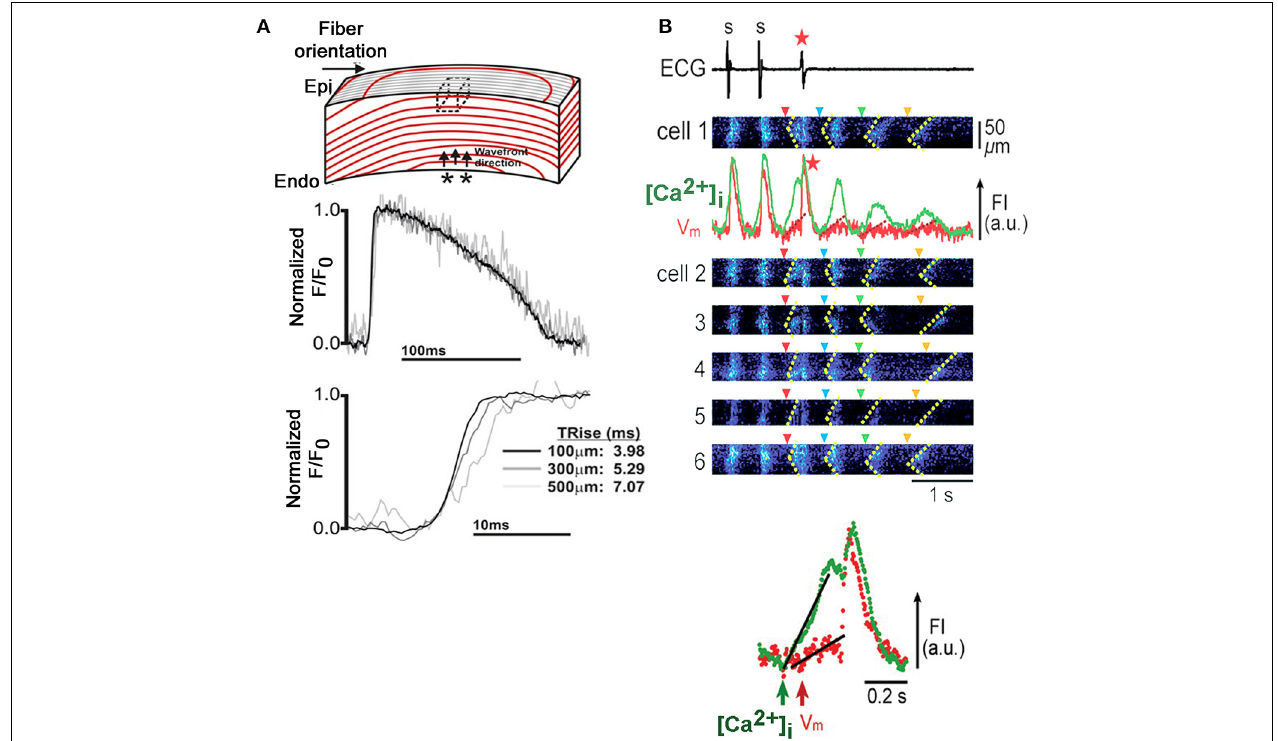
cells (1 through 6) accompanies a single event of triggered activity (red asterisk), followed by Ca 2 + oscillations (green trace), with concomitant membrane fluctuations (red trace) showing a gradual reduction in amplitude. Only the first Ca 2 + wave (red arrowhead), not the following three (blue, green and yellow arrowheads), triggers a propagating impulse. Fluorescence intensities of the calcium- and voltage-sensitive dyes fluo-4 and RH237, respectively, were measured in adjacent subepicardial ventricular myocytes withinaLangendorff-perfused ratheartwithdual-view,rapidscanningconfocal microscopy. The triggered activity was induced by 2-Hz pacing under low K + (2.4mmol/L) perfusion and isoproterenol (3nmol/L). Lower panel: Simultaneous V m and intracellular Ca 2 + recordings during the triggered beat demarcatedbytheredarrowheadintheupperpanelatanexpandedtimescale demonstrate that the increase in [Ca 2 + ] i precedes membrane depolarization. FI, fluorescence intensity; a.u., arbitrary units (Modified from Fujiwara et al., 2008. With permission from the American Heart